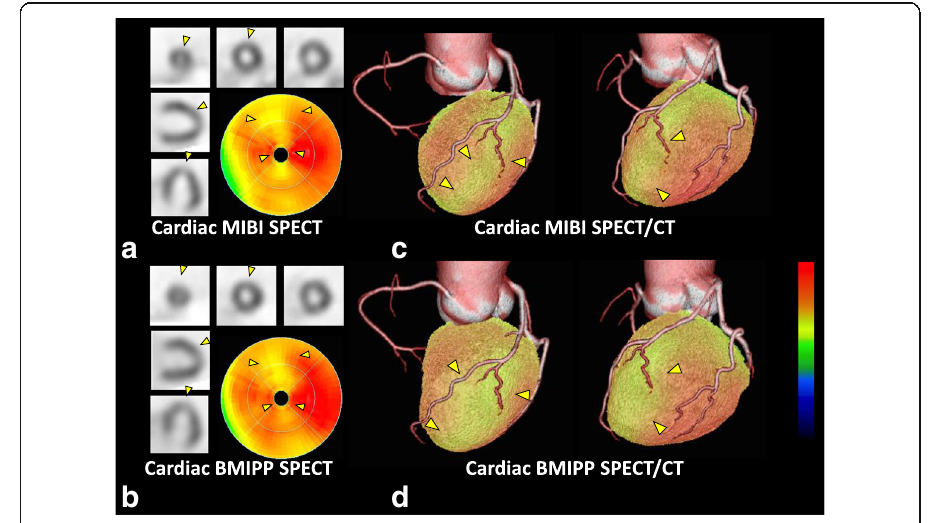
Fig. 6 60-year-old woman with ACS. Cardiac MIBI and BMIPP SPECT images show accumulation defects in the mid-distal anteroseptal to apical wall and this patient may have ACS in the LAD territory ( a , b ). SPECT/ CT fused images revealed that the accumulation defect is congruent with first diagonal branch territory, confirming ACS due to coronary vasospasm ( c , d